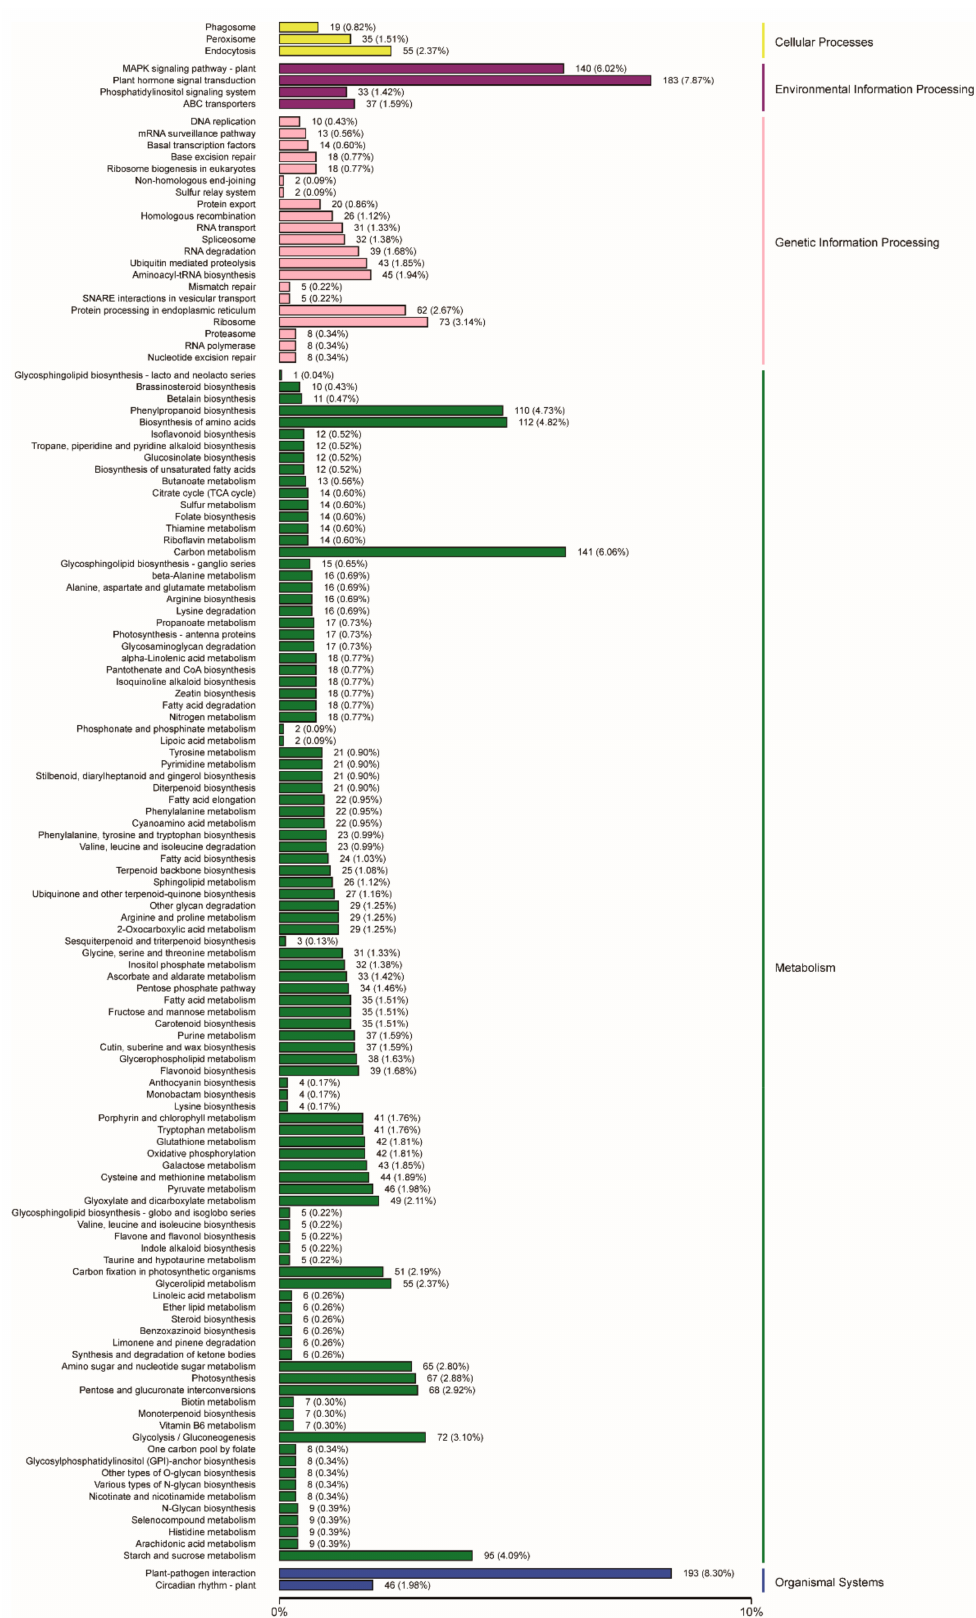
Figure 3. Functional classification and pathway assignment of DEGs by